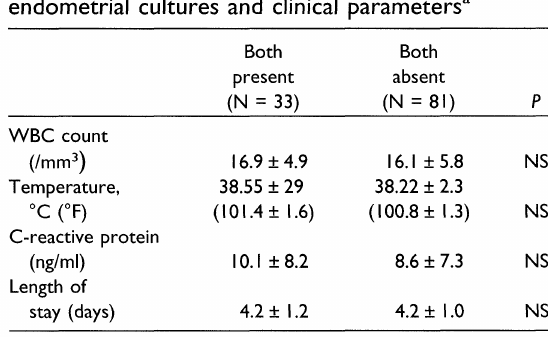
TABLE 2C. Both M. hominis and U. urealyticum in endornetrial cultures and clinical